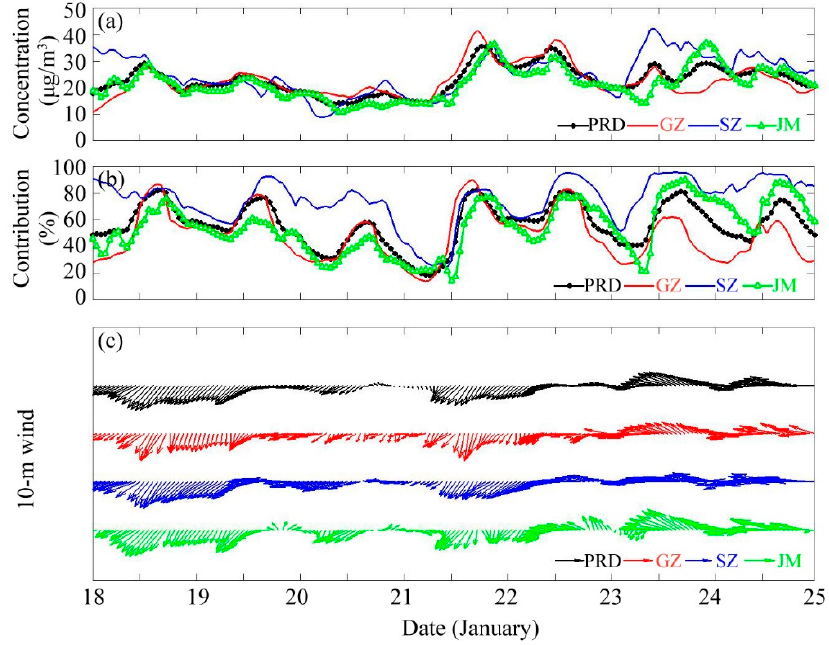
Figure 11. Contribution of the extra-regional transport of PM 2.5 to GZ, SZ, JM and the PRD from 18 to 24 January. ( a ) shows the concentration, ( b ) shows the concentration rate, and ( c ) shows the simulated surface wind in these regions (unit vector length is 4 m/s).